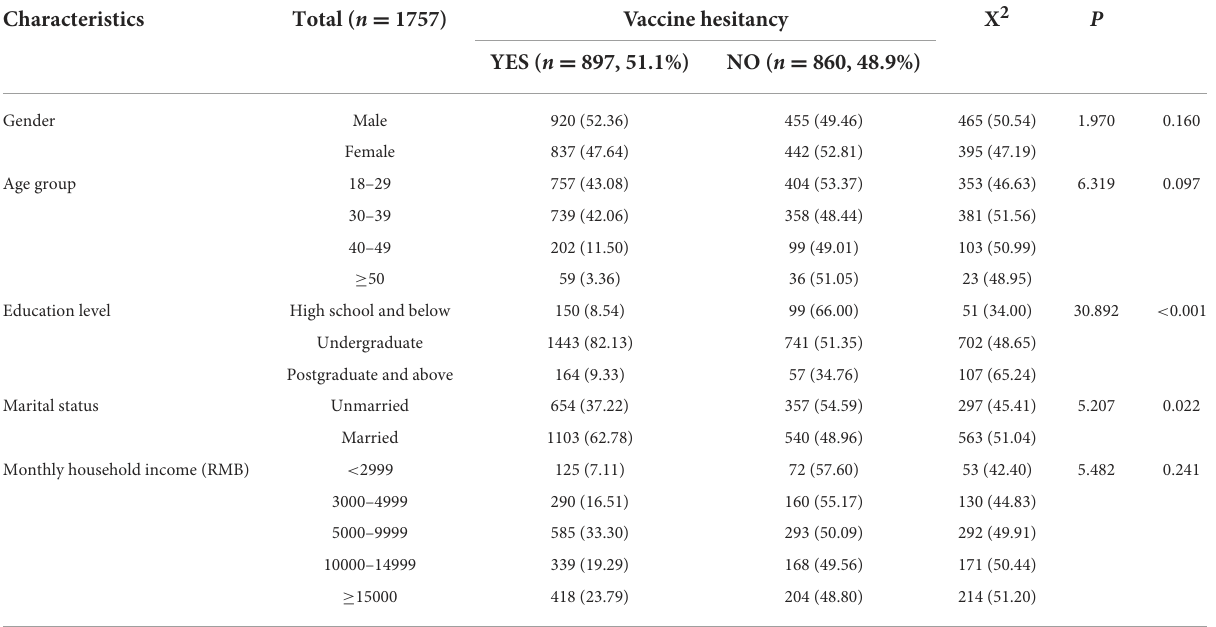
TABLE 1 Characteristics of the participants ( n =